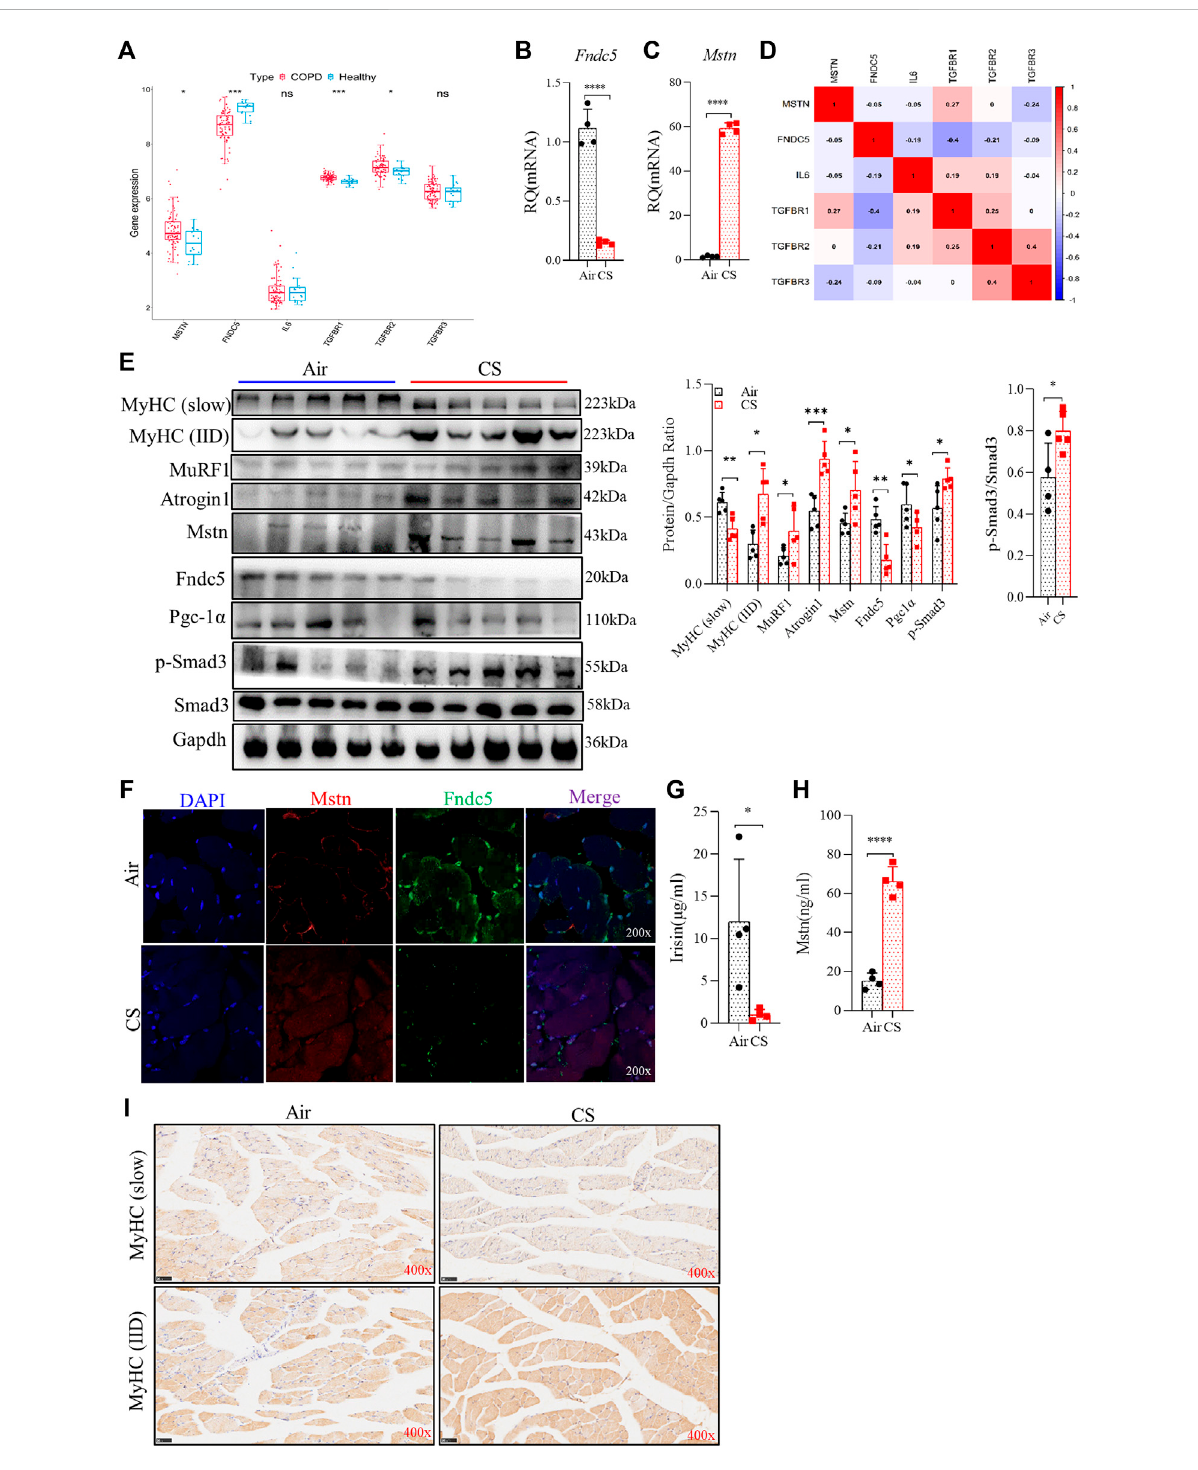
FIGURE 3 Cigarette smoke exposure attenuated fi bronectin type III domain-containing protein 5 (Fndc5)/irisin production but augment myostatin (Mstn) expression in skeletal muscles and serum, accompanied by muscle fi ber-type switch. (A) boxplot of the statistical results of some myokines and related receptors, such as Mstn, Fndc5, IL-6, TGF- β R1, TGF- β R2 , and TGF- β R3 . (B,C) real-time quantitative PCR examined the expression of Fndc5 and Mstn from gastrocnemius muscle. (D) corplot showing the correlation between Fndc5 and TGF- β R1. (E) WB explored the protein production(left),theratioofproteintoGapdh(middle),andtheratioofp-Smad3toSmad3(right). (F) expressionofFndc5andMstndistributedinthe gastrocnemius muscle using confocal microscopy. (G,H) levels of irisin and Mstn in serum were detected using ELISA. (I) expression of MyHC (slow) and MyHC (IID) were explored using immunohistochemistry. n = 5, * p < 0.05, ** p < 0.01, *** p < 0.001, **** p < 0.0001, ns: not signi fi